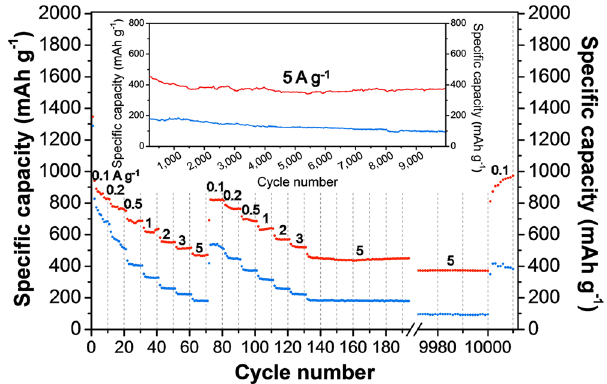
Figure 5. Rate performance (discharge capacities) of SnO 2 @C@half-rGO (red) and SnO 2 @C/rGO (blue). The varying current is 100, 200, 500, 1000, 2000, 3000 and 5000 mA g − 1 for 10 cycles each, following 100– 3000 mA g − 1 for 10 cycles each again, and 5 A g − 1 for 9870 cycles until the final 100 mA g − 1 for 10